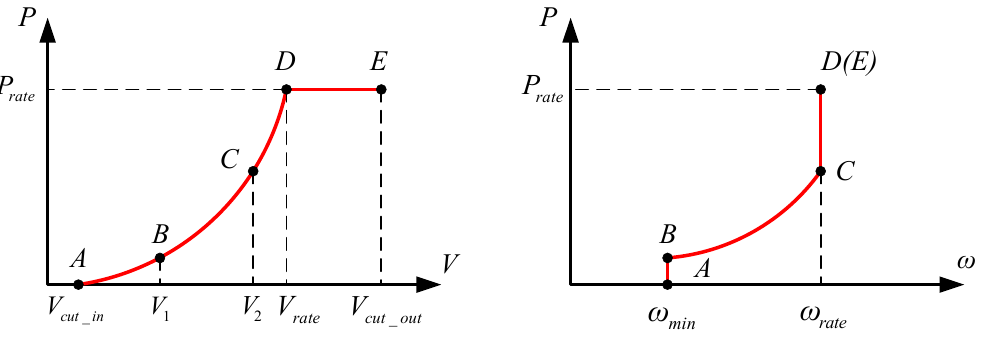
Figure 6. Theoretical working conditions classification.